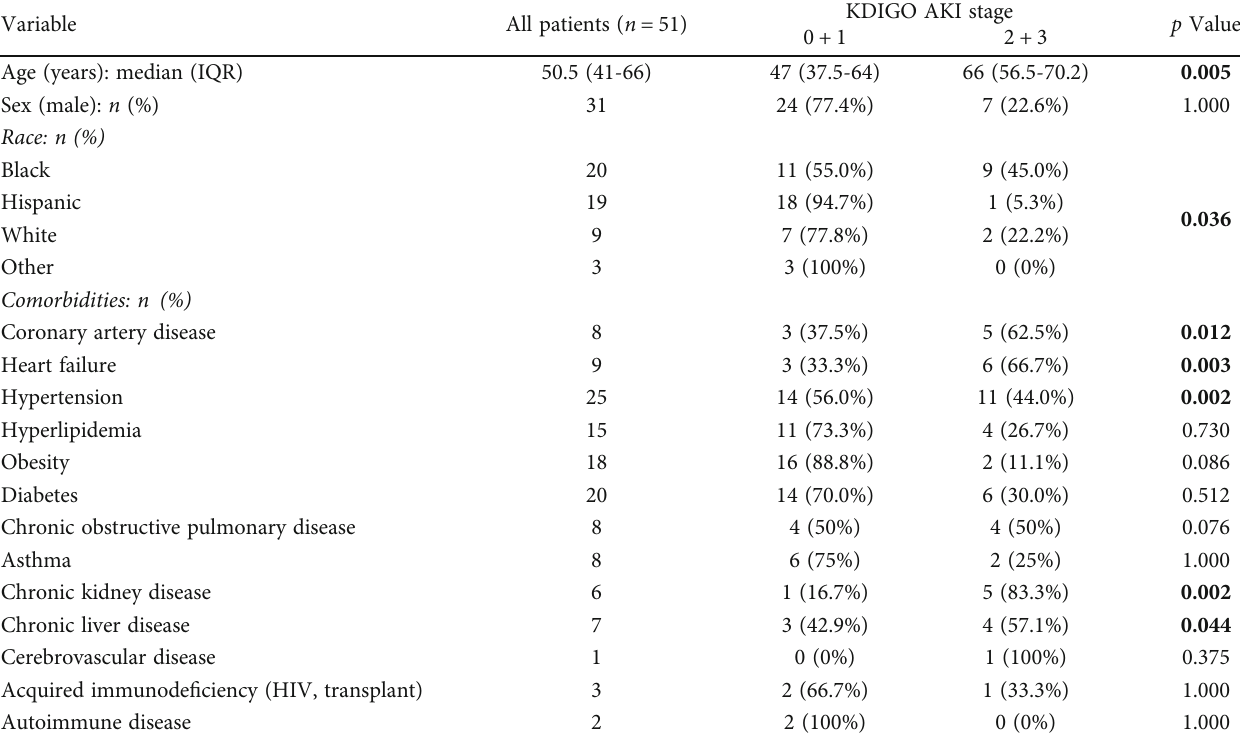
Table 1: Baseline demographics of the Cincinnati Emergency Department COVID-19 cohort. Variable All patients ( n = 51